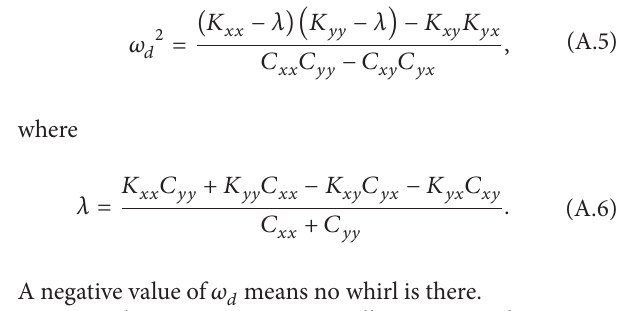
Figure 15: Variation of threshold speed 𝜔 𝑠 as a function of characteristics length “ l m